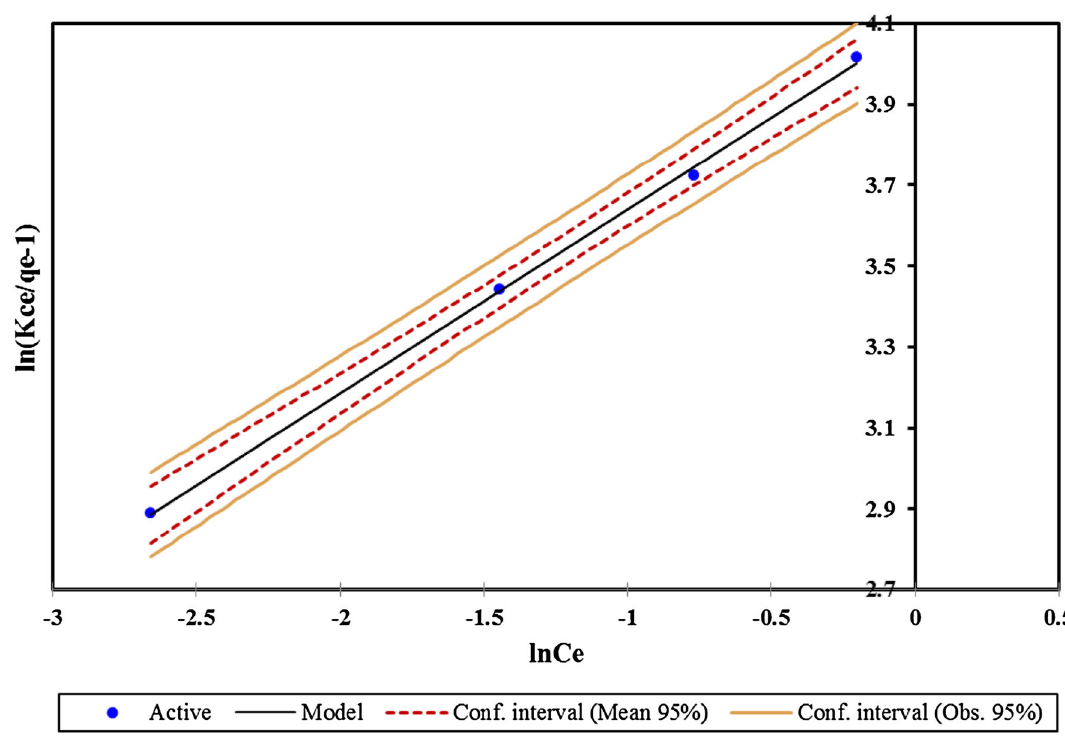
Fig. 3 Redlich–Peterson isotherm obtained using the linear method for the sorption of fluoride onto